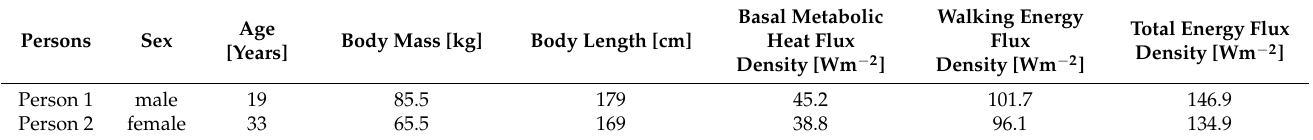
Table 1. Human state variables and metabolic heat flux densities of a man representing the average Hungarian man and a woman representing the average Hungarian